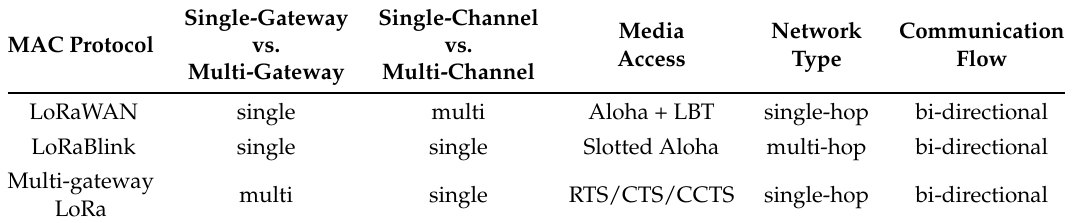
Table 2. LoRa medium access communication (MAC) protocol overview. RTS: Request To Send; CTS: Clear To Send; CCTS: Control